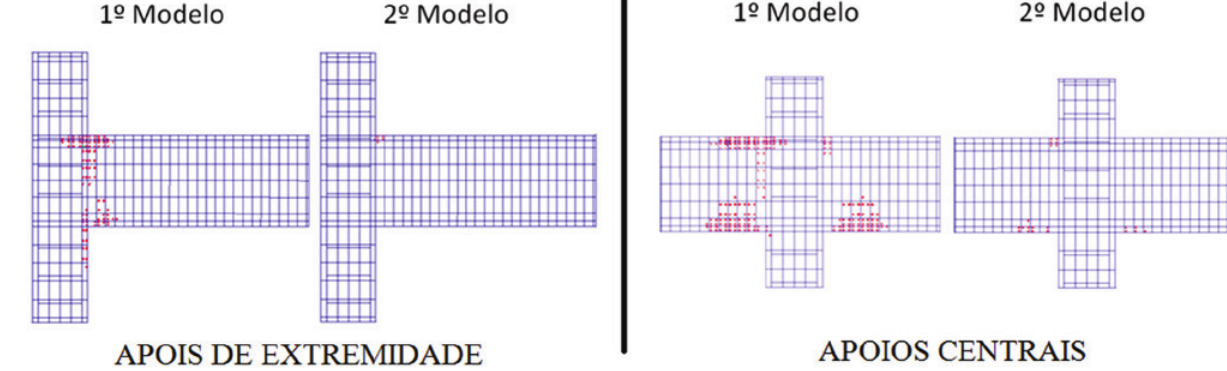
Figura 11 Vista detalhada das regiões A e